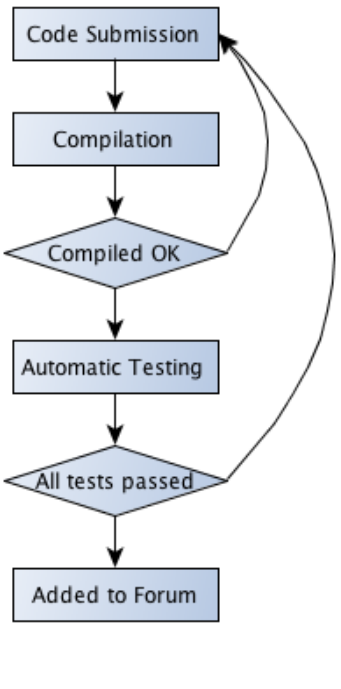
Figure 2. Schematic workflow for a student submission to WebTasks.